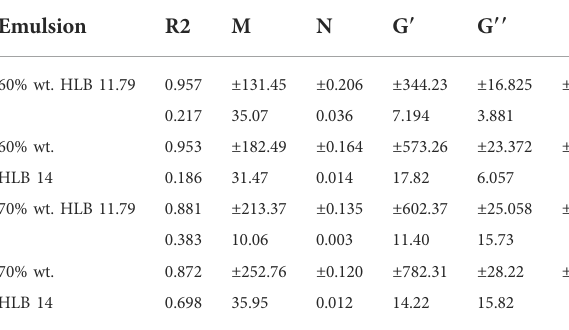
TABLE 2 Rheological parameters of bare O/W emulsions at two different concentrations of dispersed phase and two different values of HLB. The values of m and n were recovered from the power law. R2 is the correlation coef fi cient for data fi tting to the power law. While G 9 and G 99 correspond to the mean values of each modulus and the corresponding standard